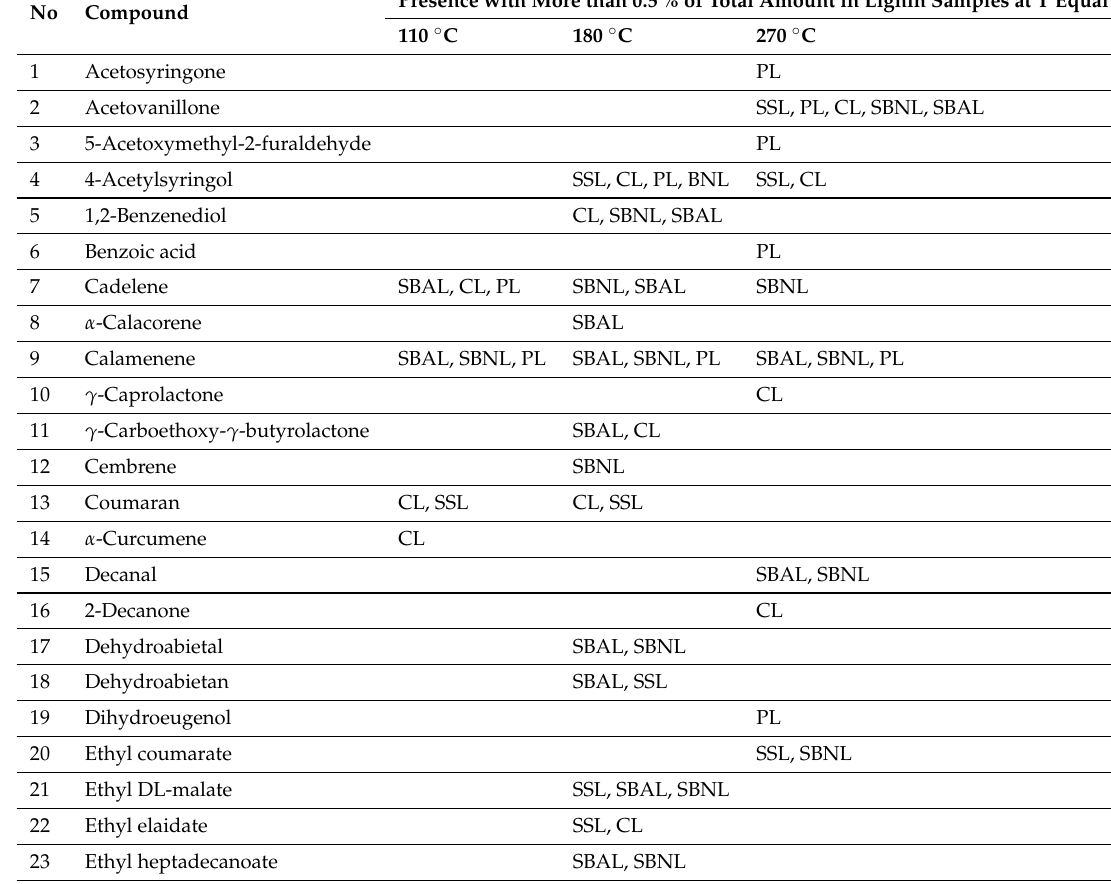
Table 5. List of identified compounds from HSGC-MS analysis at headspace oven temperature of 110, 180, 270 ◦ C of lignin fractionated from pine sawdust (PL), cotton stalks (CL), sweet sorghum (SSL), spruce bark with an acid catalyst (SBAL) and spruce bark without the acid catalyst